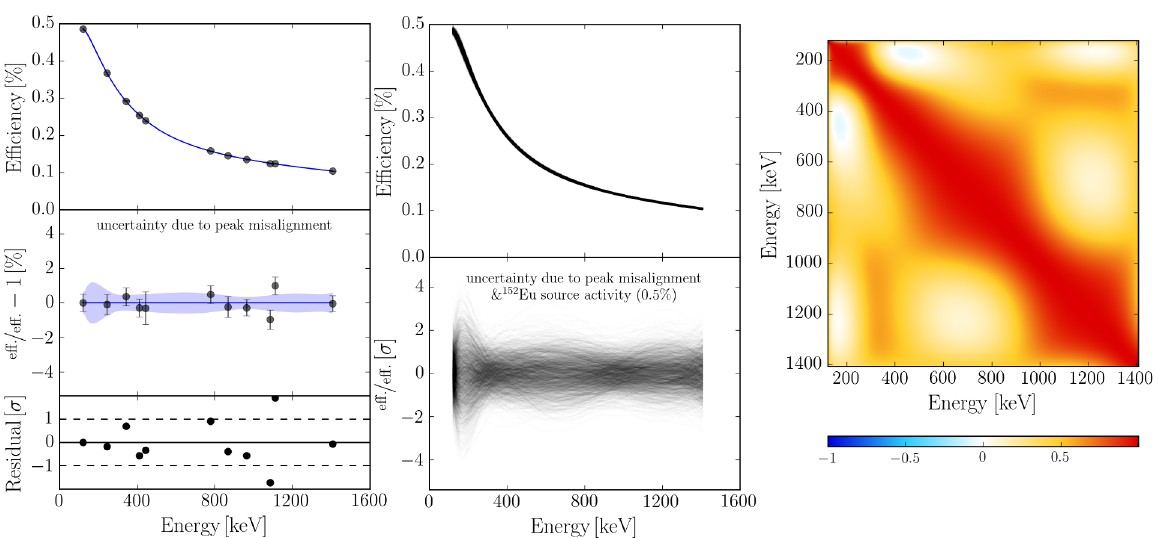
Figure 4: HPGe efficiency calibration procedure using a 152 Eu source. Left: experimental efficiency as a function of energy (black points) and fitted curve considering only the peak uncertainty (blue curve). Middle: Monte Carlo sampling from correlated fit parameters and incorporation of the 0.5 % source activity uncertainty (100 % correlated on the spectrum). Right: Covariance matrix associated to the sampled efficiency